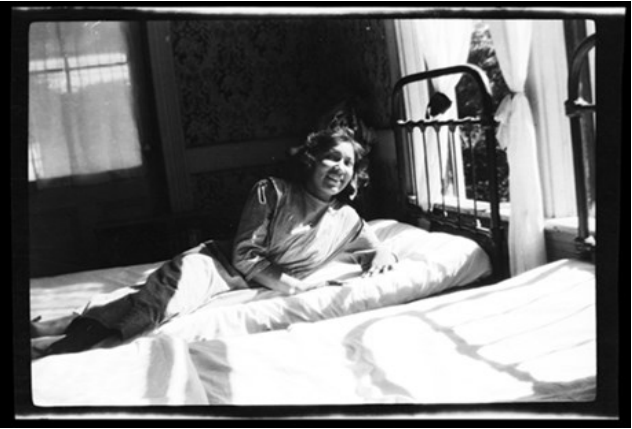
Figure 15. Nettie Odlety, Inside the Girls’ Dormitory—Phoenix Indian Boarding School, c. 1915. Parker McKenzie Collection. Courtesy of the Oklahoma Historical